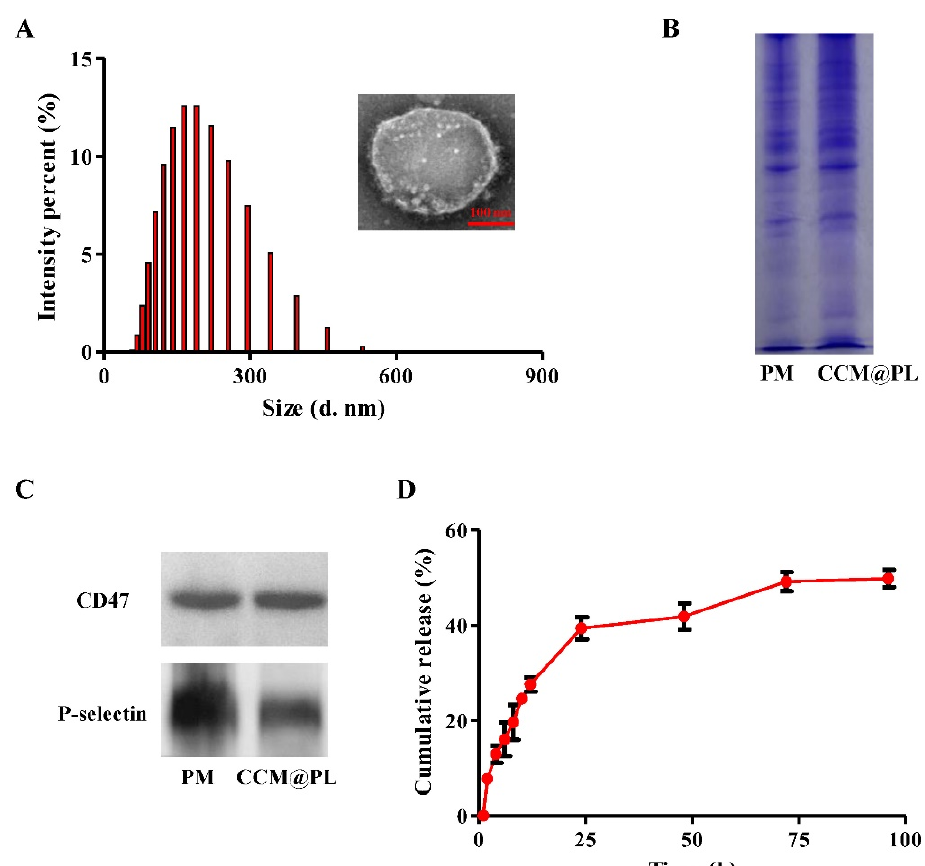
Figure 1. Characterization of CCM@PL. ( A ) Size distribution and transmission electron microscopy (inset) images of CCM@PL. ( B ) SDS–PAGE of CCM@PL and PM. ( C ) Western blotting of CCM@PL and PM. ( D ) In vitro cumulative drug release of CCM@PL.